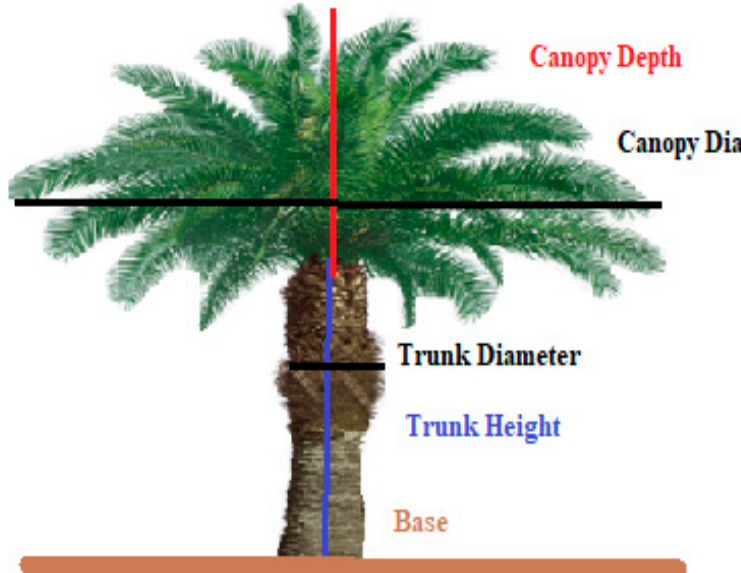
Figure 3. Nomenclature of the oil palm tree. Table 1. Measurement of oil palm tree characteristics.